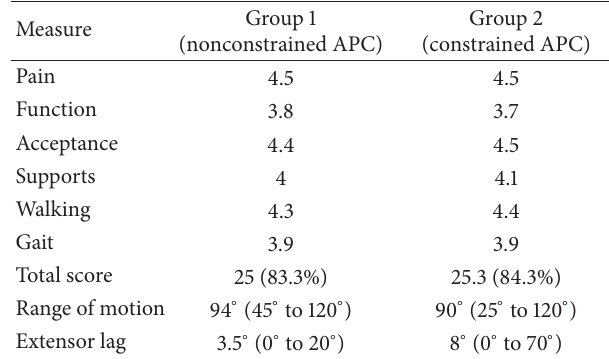
Table 3: Features of patients with fractures.